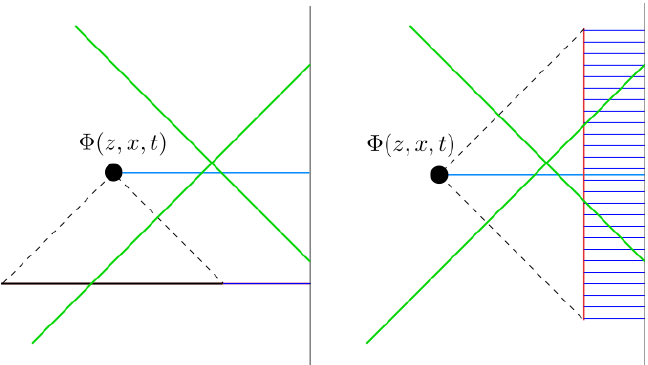
Figure 6 . We can exploit the spacelike HKLL procedure to write an operator whose dressing crosses multiple shockwaves as a linear combination of operators whose dressing crosses less